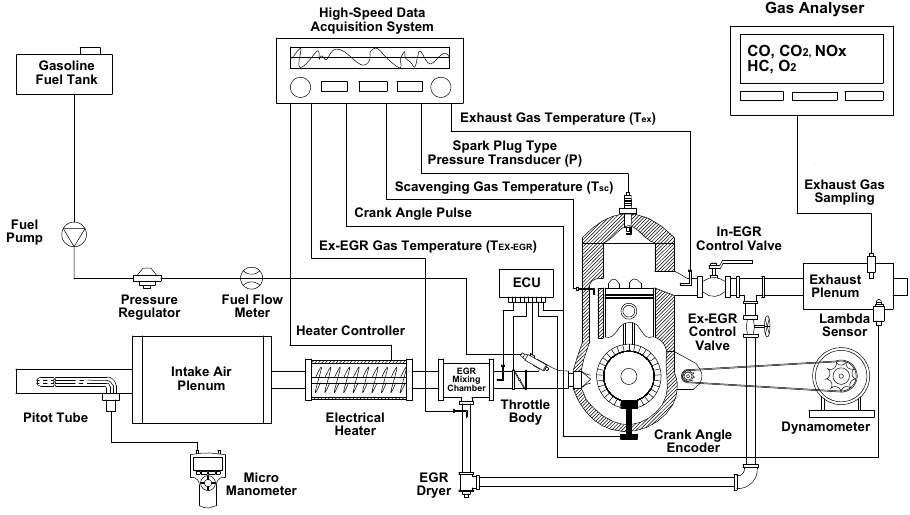
Figure 2. Schematic view of experimental test rig setup.